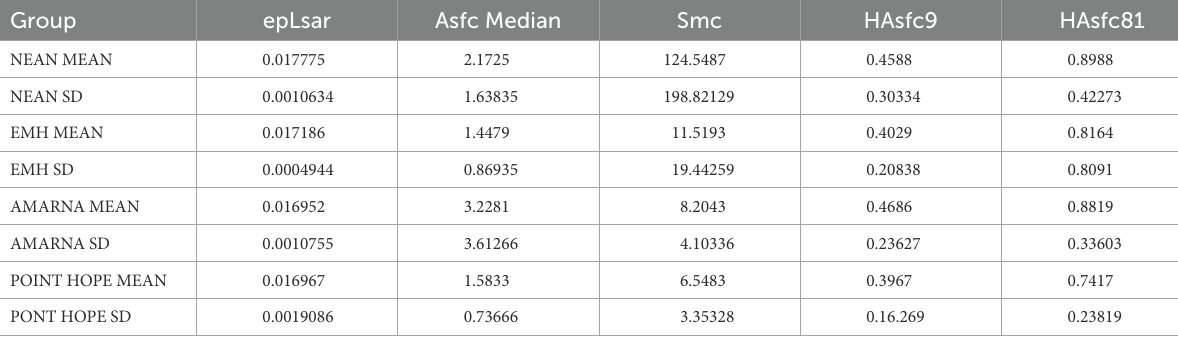
TABLE 1 Summary descriptive statistics for the groups studied.